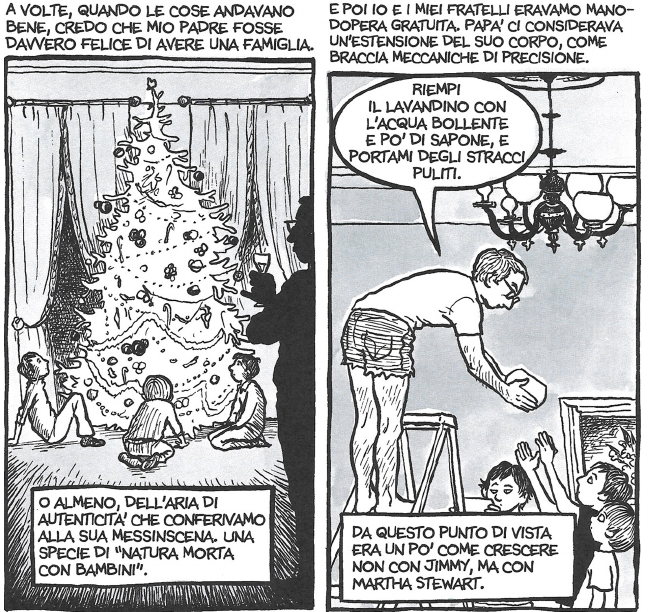
Fig. 3 One of the pages of Fun Home that shows the relationship of Bruce Bechdel with his three children (Bechdel, 2007, p.